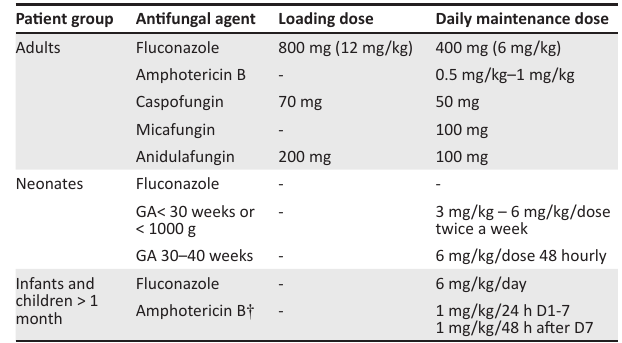
TABLE 9: Recommended antifungal agents and doses for prophylaxis among adults and